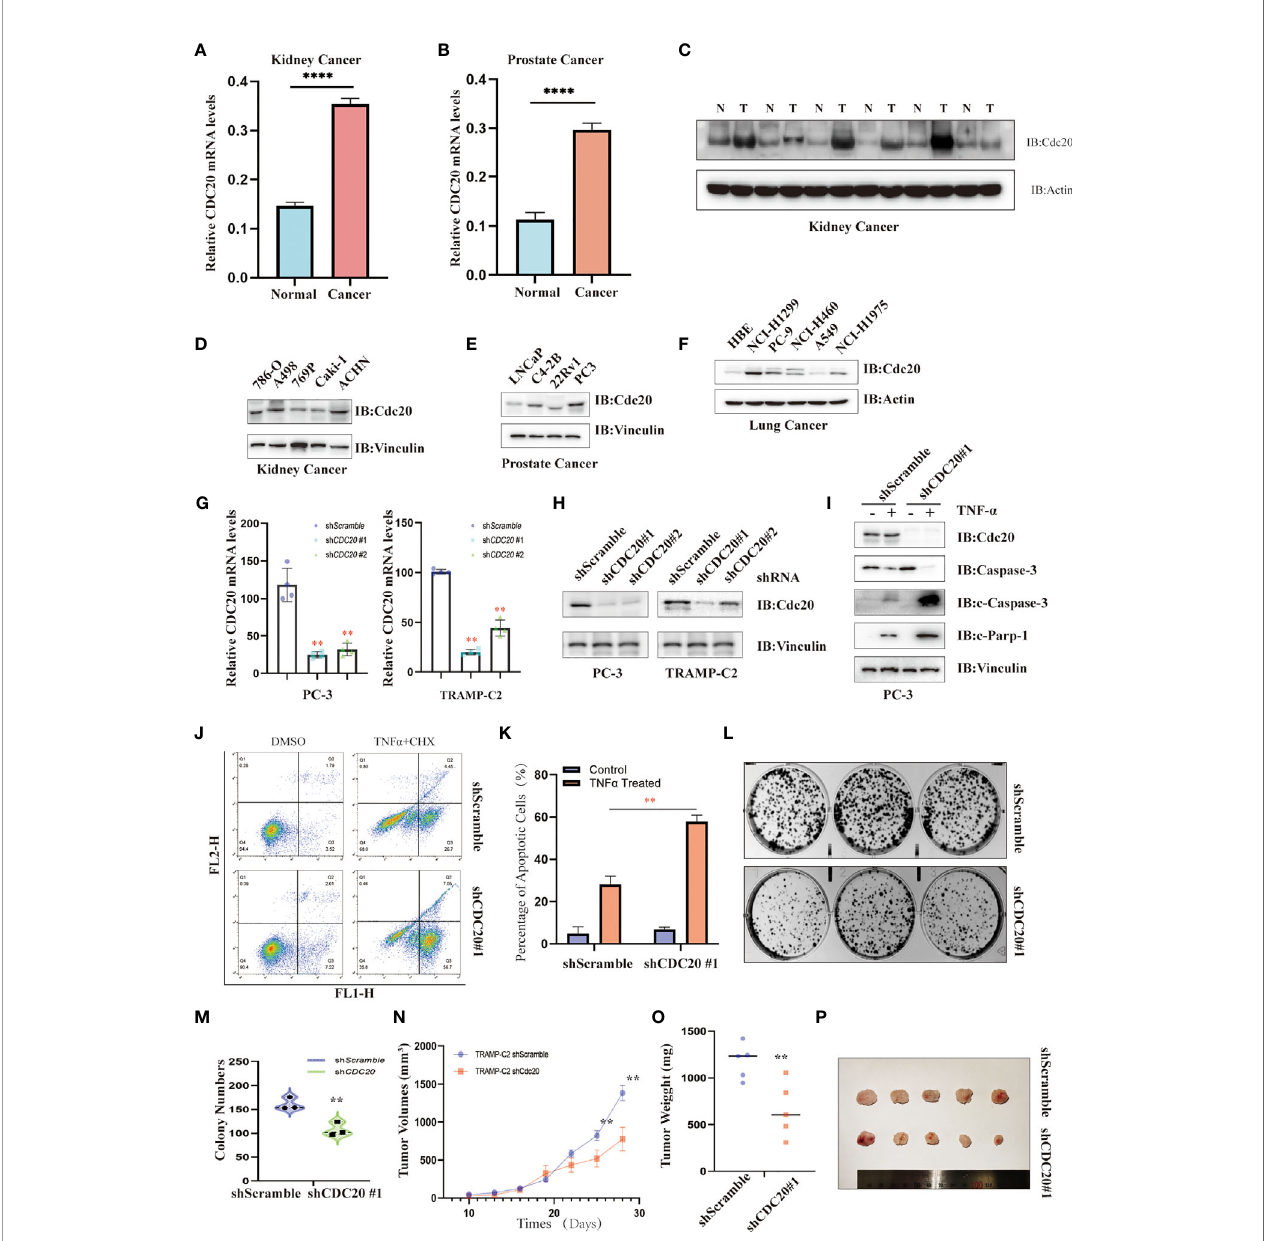
FIGURE 7 | The functional validation of Cdc20. (A, B) Oncopression database was utilized to verify the differential expression of CDC20 in the kidney (A) and prostate cancer (B) , as well as their matched normal tissues. **P < 0.01. (C) Immunoblotting was used to detect the abundance of Cdc20 levels in tumor tissues (T) and matched normal tissues (N) of renal cell carcinoma. (D – F) Immunoblotting was used to detect the abundance of Cdc20 levels in cancer cell lines derived from kidney cancer (D) , prostate cancer (E) , and lung cancer (F) . (G) Quantitative RT-PCR was utilized to detect the relative CDC20 mRNA levels in PC-3 and TRAMP-C2 cell lines with or without CDC20 stably knockdown, respectively. (H) Immunoblotting was used to detect the abundance of Cdc20 levels in PC-3 and TRAMP-C2 cell lines with or without CDC20 stably knockdown, respectively. (I) Immunoblotting was used to detect the abundance of Cdc20 and apoptosis markers in PC-3 with or without CDC20 stably knockdown treated with TNF- a (20 ng/ml) and Cycloheximide (10 m M) for 4 hours before sampling. (J, K) Annexin-V and Propidium Iodide staining followed by FACS analysis to detect the proportion of apoptotic PC3 cells with or without CDC20 stably knockdown treated with TNF- a (20 ng/ml) and Cycloheximide (10 m M) for 4 hours before staining (J) . The quanti fi cation of three independent replicates was statistically analyzed and visualized (K) . (L, M) The representative photograph of colonic formation results in PC3 cells with or without CDC20 stably knockdown (L) . The quanti fi cation of three independent replicates was statistically analyzed and visualized (M) . (N – P) A subcutaneous tumor mouse model was generated by injection of 5*10 5 TRAMP-C2 cells with or without knockdown of CDC20 in immune-competent C57BL/6J mice. The tumor volume (N) and weight (O) were recorded and statistically analyzed. Tumor xenografts of each group are shown (P) . **P < 0.01; ****P <